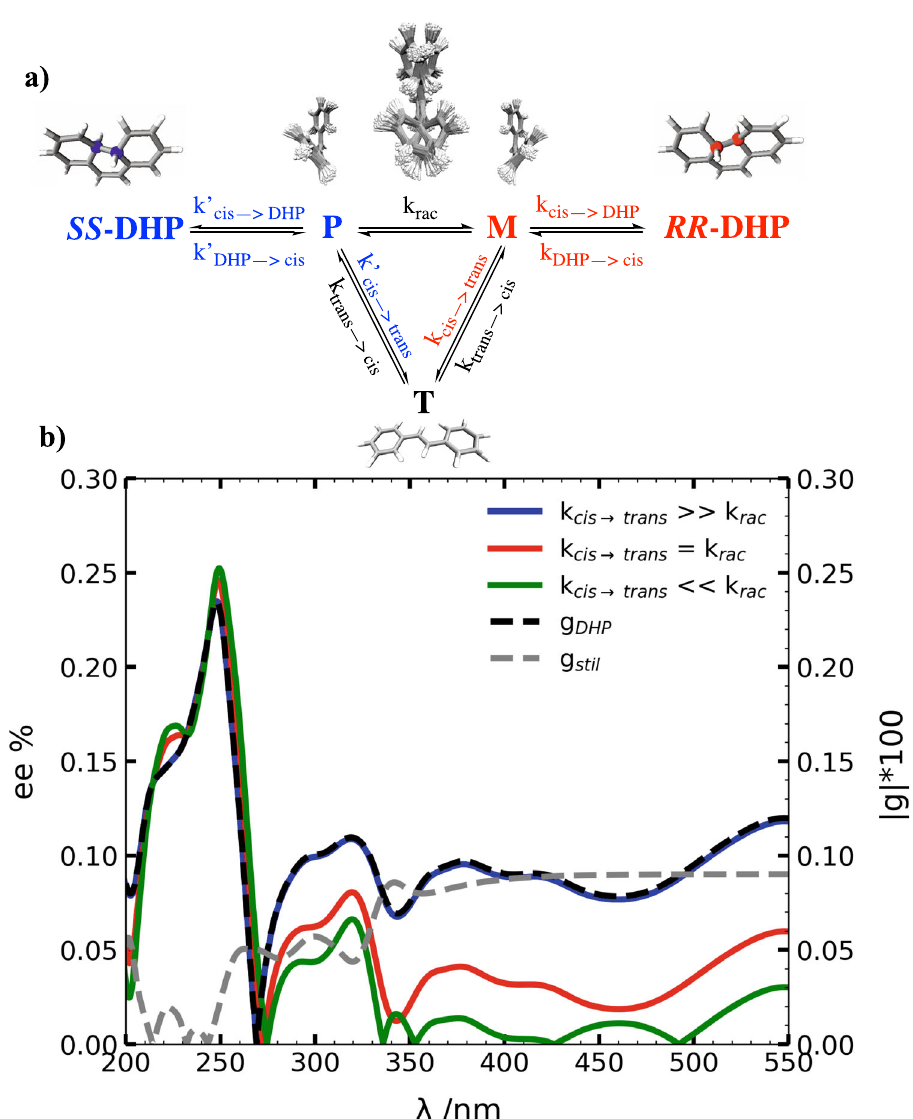
Fig. 4 Asymmetric photochemistry in stilbene. a Kinetic model employed to describe the photochemistry of cis -stilbene. In agreement with the results of the AIMS dynamics, we are assuming that the cis-trans isomerization and the DHP cyclization require photoexcitation whereas the helical inversion process takes place only on S 0 . Thus, the excitation of the M and P enantiomers can lead to photocyclization to R,R -DHP or SS -DHP with kinetic constants k cis → DHP and k ’ cis → DHP or photoisomerization to the achiral trans -stilbene (T) with kinetic constants k cis → trans and k ’ cis → trans , respectively. At the same wavelength, the DHP enantiomers can be excited back leading to the M and P enantiomers with kinetic constants k DHP → cis and k ’ DHP → cis . trans -Stilbene can also be excited, producing both P and M cis -stilbene conformations ( k trans → cis ). P and M are considered to be in equilibrium in the ground state with a helical inversion constant k rac . b Enantiomeric excess reached at the photo-stationary state exciting a racemic mixture of the P and M enantiomers of cis -stilbene with r-CPL as a function of the excitation wavelength. Three limiting cases were considered according to Eq. (1). The wavelength-dependent g factors for stilbene ( g stil ) and DHP ( g DHP ) are also reported as dashed lines. In the optical window 250 – 350 nm, the M -enantiomer preferentially absorbs the r-CPL leading to trans- stilbene and R , R -DHP (Supplementary Fig. 4a). Th latter is also preferentially excited by the r-CPL retrieving cis -stilbene and resulting in an overall optical enrichment of S,S -DHP. On the other hand, in the optical window 200 – 270 nm (Supplementary Fig. 4b), the band in the DHP ECD spectrum changes sign and the r-CPL is preferentially absorbed by the S , S -DHP enantiomer (i.e., the anisotropy factor g changes sign). In this way, the optimum condition to maximize the ee is reached since one enantiomer is preferentially formed and the other destroyed by the CPL irradiation, resulting in an overall excess of R,R